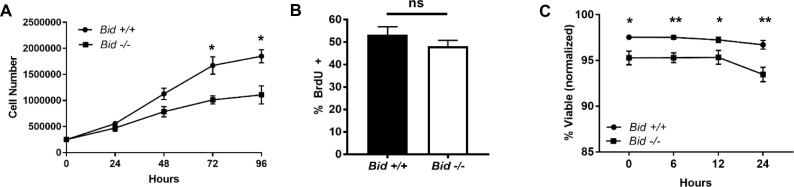
Loss of Bid results in increased cell death in the absence of an apoptotic stimulus.(A) Bid-/- MPCs display decreased growth rates (n = 4) but not proliferation rates (B) in complete media (n = 3). (C) Viability assay of Bid +/+ and Bid-/- cells in complete media (n = 7). Data were normalized to no treatment. P-values were determined by unpaired Student’s t-test for (A–C). Error bars indicate ±SEM for all data. ns = not significant, *p<0.05, **p<0.01, and ***p<0.001.